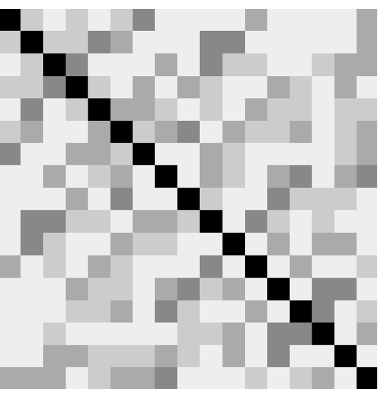
Figure 5: The structure of the channel matrix in the synchronous case.